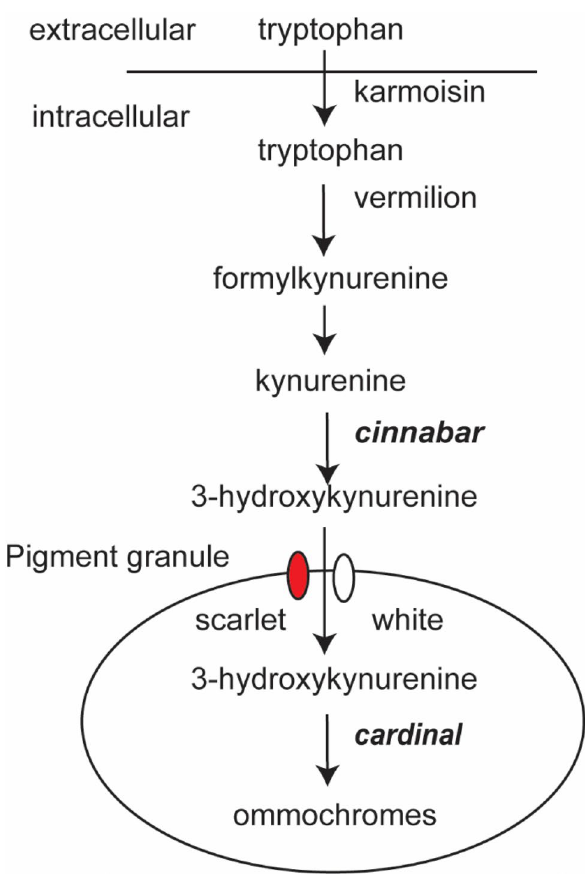
Figure 1. The insect ommochrome eye pigmentation pathway. Genes involved are karmoisin , vermilion , cinnabar , scarlet , white , and cardinal . Genes targeted for gene function in L. hesperus are